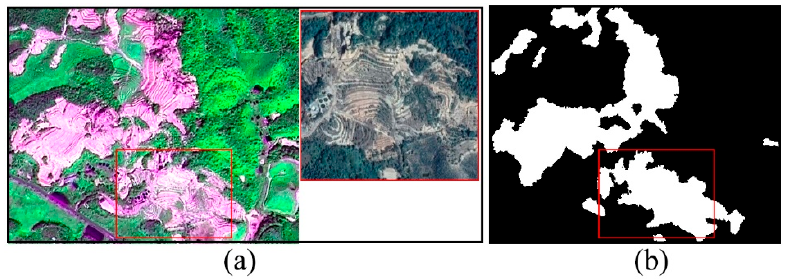
Figure 11. Partial reclamation area mixed with REO mined area. ( a ) The source image, with the reclamation area framed in the red rectangle; ( b ) experimental result.